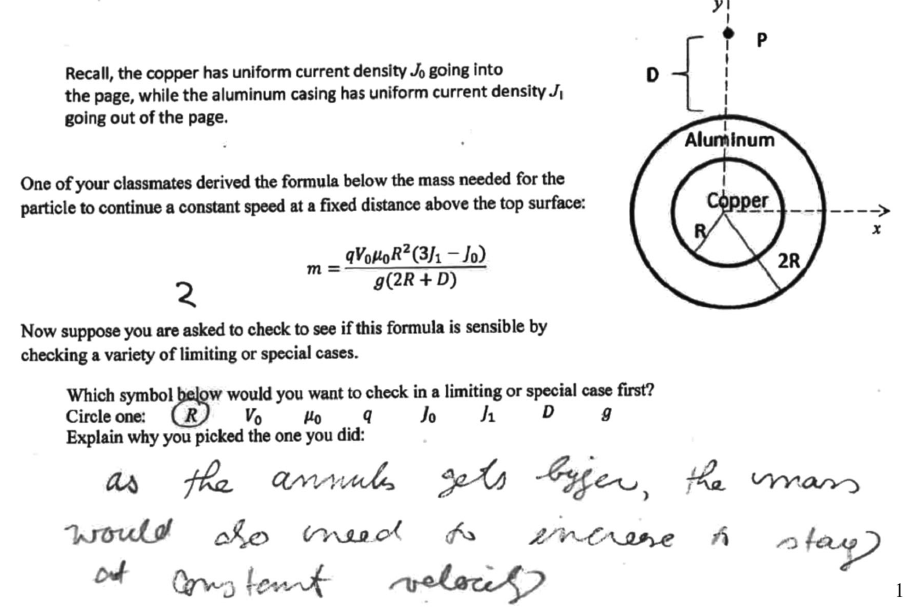
FIG. 4. Example prompt from the electricity and magnetism class asking students to describe their choice of limiting cases. Student selects R because as the annulus gets bigger, the mass would also need to increase to stay at constant velocity (Images of student work are modified to improve readability).